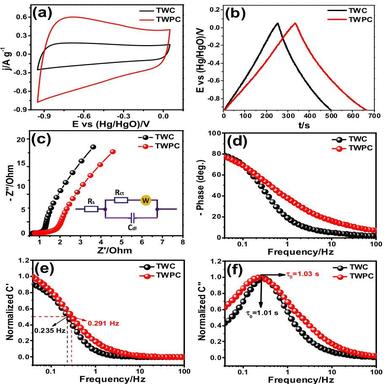
(a) CV curves at a scan speed of 2 mV s1 , (b) GCD curves at a CD 1 A g1 , (c) Nyquist plots, (d) Bode phase diagrams, (e) Normalized real part capacitances and (f) Normalized imaginary part of capacitances of the TWC and TWPC electrodes.